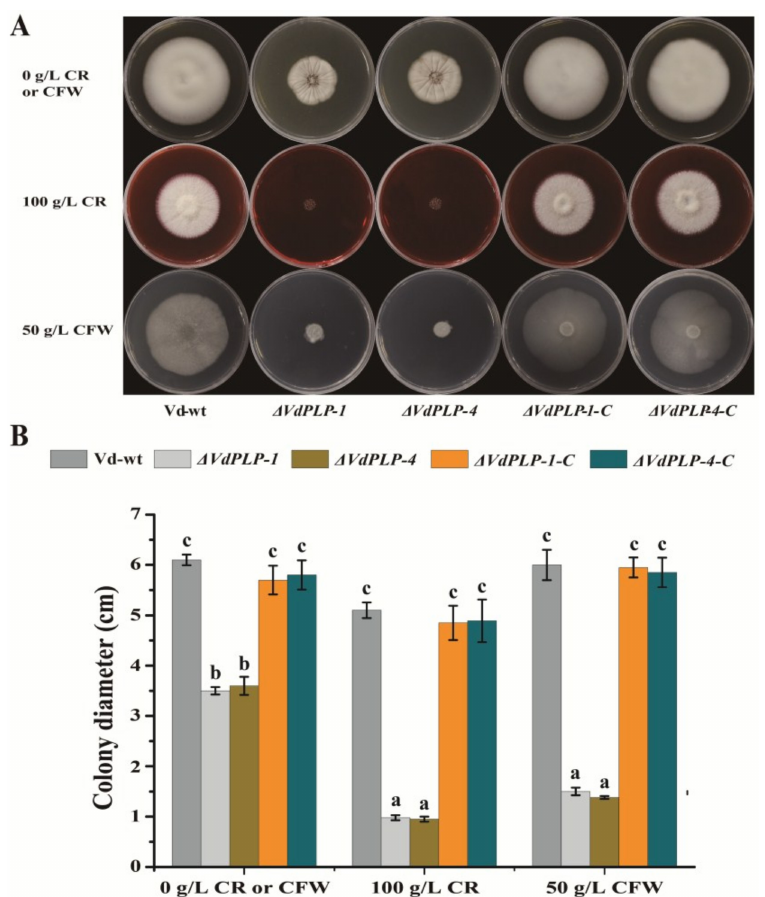
Figure 4. Effect of cell-wall-perturbing agents calcofluor white (CFW) and Congo red (CR) on growth of Vd-wt, ∆ VdPLP ( ∆ VdPLP-1 and ∆ VdPLP-4 ) strains, and complementary ∆ VdPLP ( ∆ VdPLP-1-C and ∆ VdPLP-4-C ) strains. ( A ) Colonies of Vd-wt, ∆ VdPLP ( ∆ VdPLP-1 and ∆ VdPLP-4 ) mutant strains, and complementary ∆ VdPLP mutant ( ∆ VdPLP-1-C and ∆ VdPLP-4-C ) strains after 15 days on potato dextrose agar (PDA) plates containing 100 g/L CR or 50 g/L CFW compared with controls on PDA at 25 ◦ C. ( B ) Mean ( ± SD) colony diameter after 15 days on PDA plates with 100 g/L CR or 50 g/L CFW compared with controls on PDA. Three independent replicates were done; Different letters (a–c) above the bars represent the significant differences among the groups and were analyzed with the Duncan’s multiple range test ( p -value <